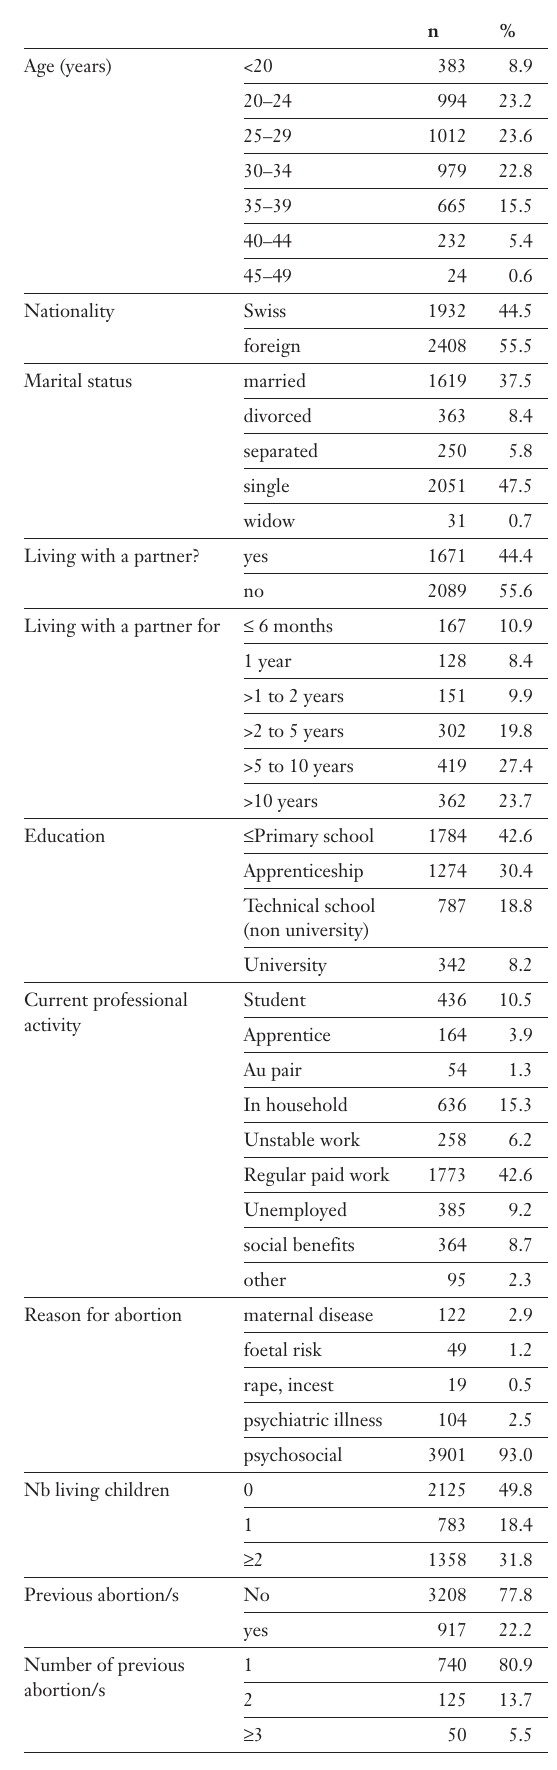
Table 1 Reproductive and demographic charac- teristics of women who requested an abortion between 1997 and 1999 in Vaud, Switzerland (n =